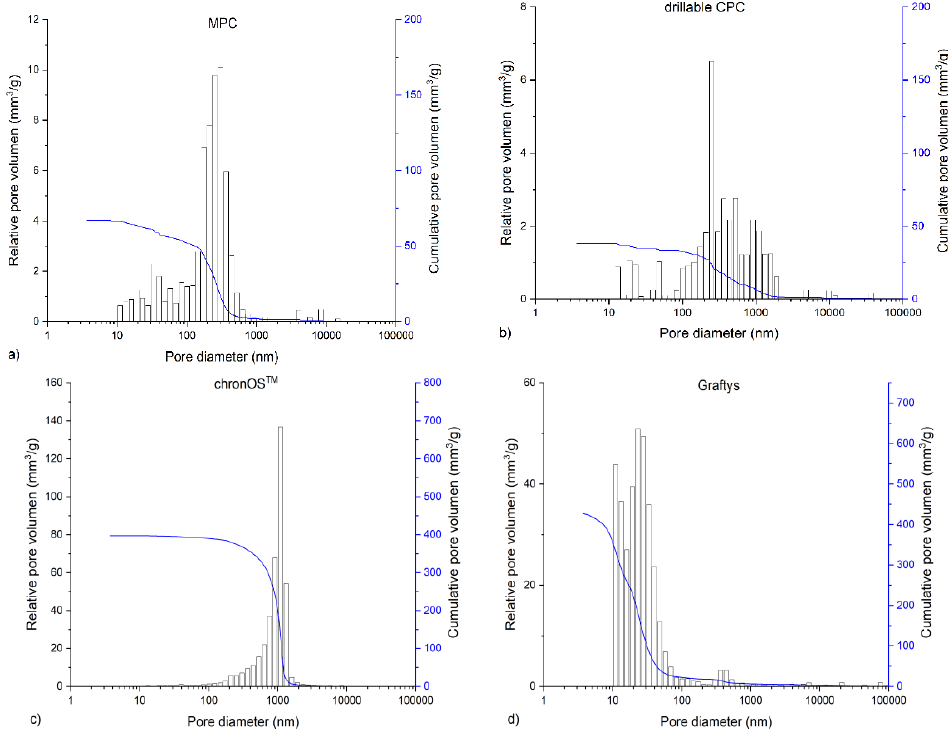
Figure 6. Graphs of mercury porosity analysis. Displayed are the graphs of the mercury porosity analysis for each bone substitute used in the study, ( a ) Magnesium phosphate cement; ( b ) Dual setting α -TCP / HEMA cement; ( c ) ChronOS TM Inject; ( d ) Graftys ® Quickset. Relative pore volume (mm 3 / g) as well as cumulative pore volume (mm 3 / g) as a function of pore diameter are shown. Lowest cumulative porosity for in-house formulations and largest pores in ChronOS TM were determined: An equivalent low cumulative pore volume was found for the drillable CPC and MPC, whereas the commercial formulations showed distinctly higher cumulative pore volumes. The highest average pore volume and median pore volume were determined for ChronOS TM Inject.